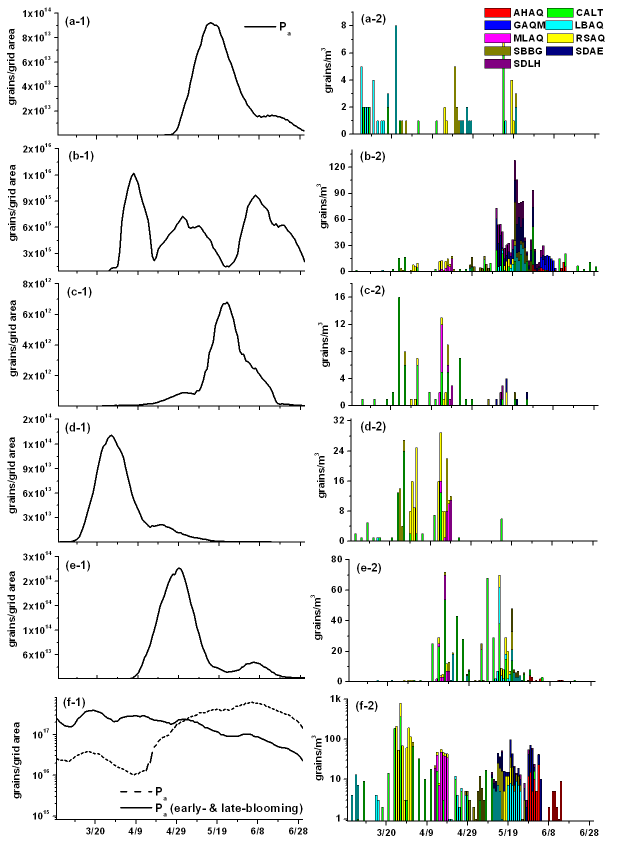
Fig. 4. Temporally-aligned pollen emission potentials P a (left col- umn) and observed pollen counts (right column) for (a) birch, (b) grass, (c) walnut, (d) mulberry, (e) olive, and (f) oak.